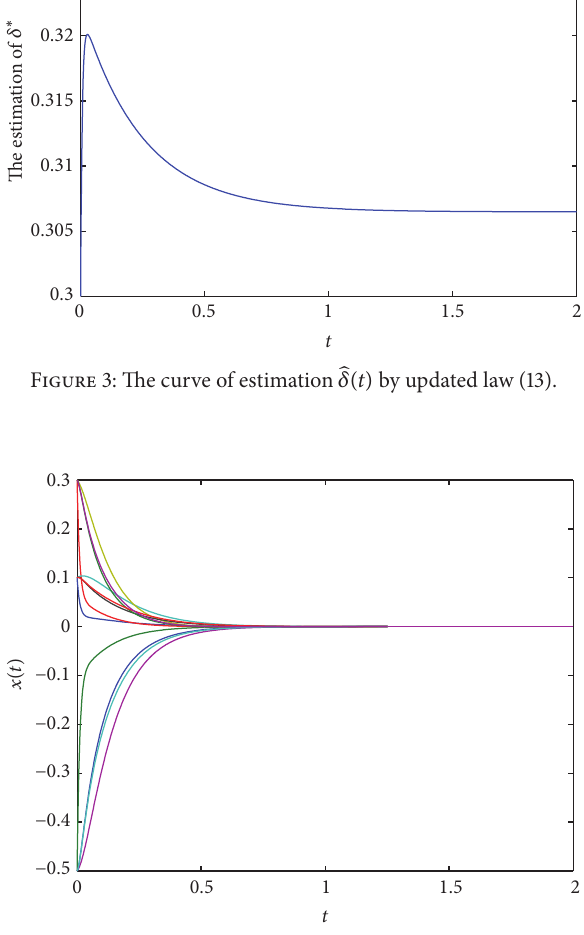
Figure 4: The state response of the closed-loop system by controller (30).